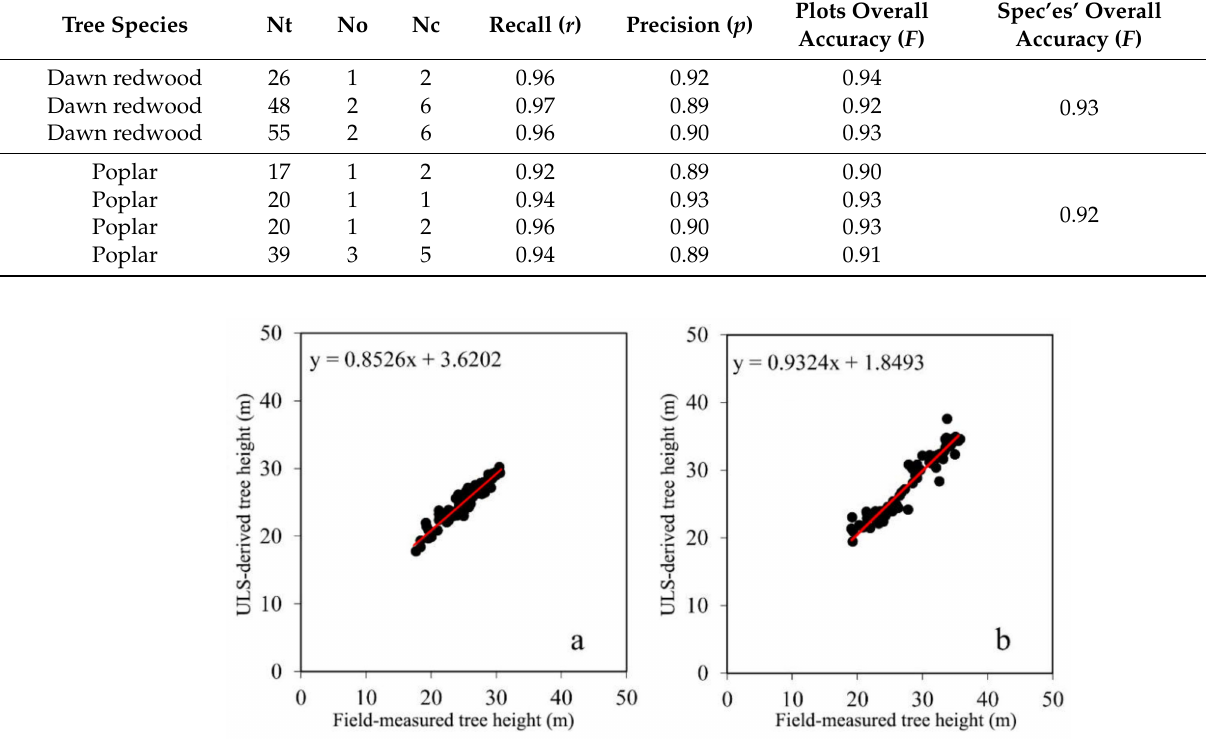
Figure 3. Scatterplots of ULS-derived and field-measured tree height. ( a ) Dawn redwood, ( b ) poplar.